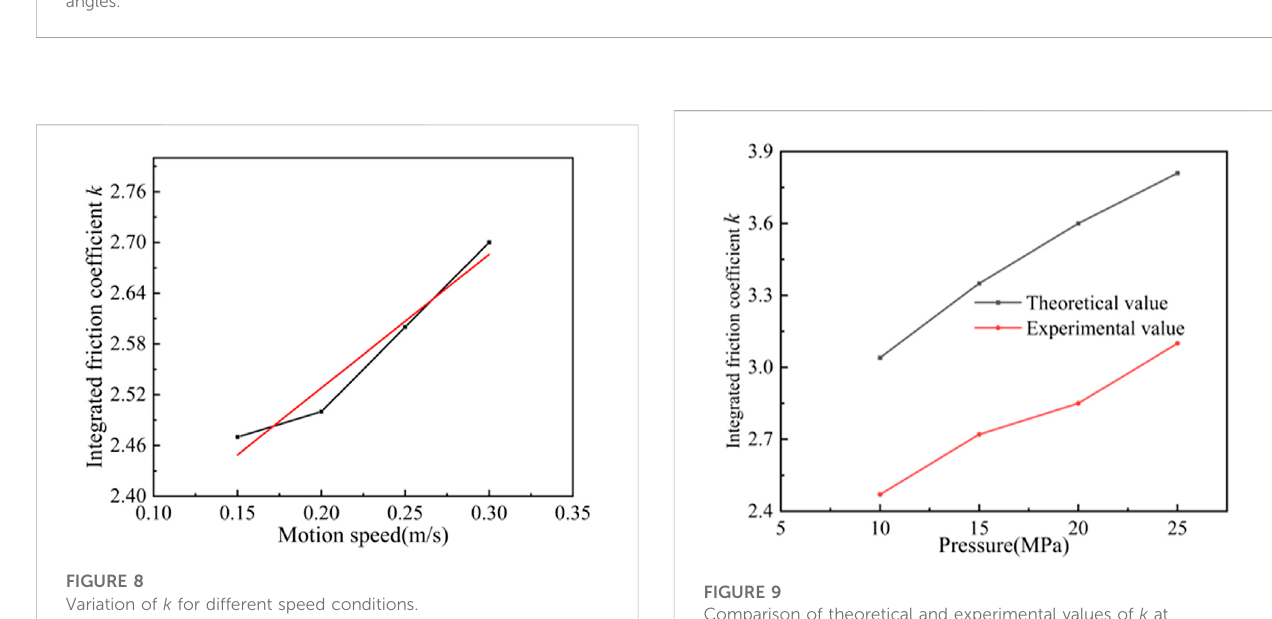
FIGURE 7 Law of change of resistance at different angles (A) 10 MPa Change of resistance at different angles (B) 15 MPa Change of resistance at different angles.